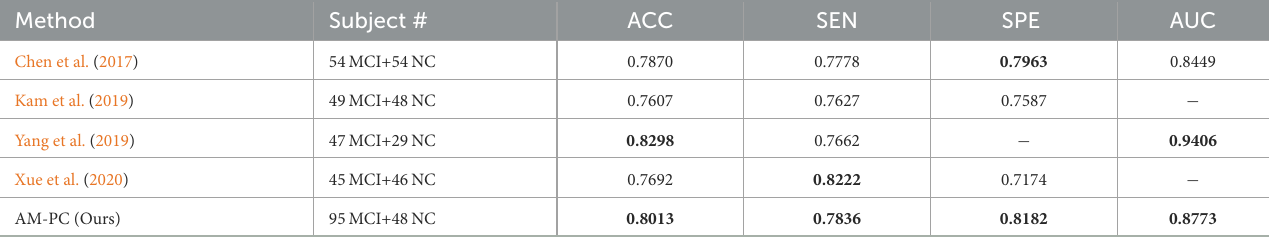
TABLE 3 Comparison with state-of-the-art methods for FBN-based MCI vs. NC classification with rs-fMRI data from